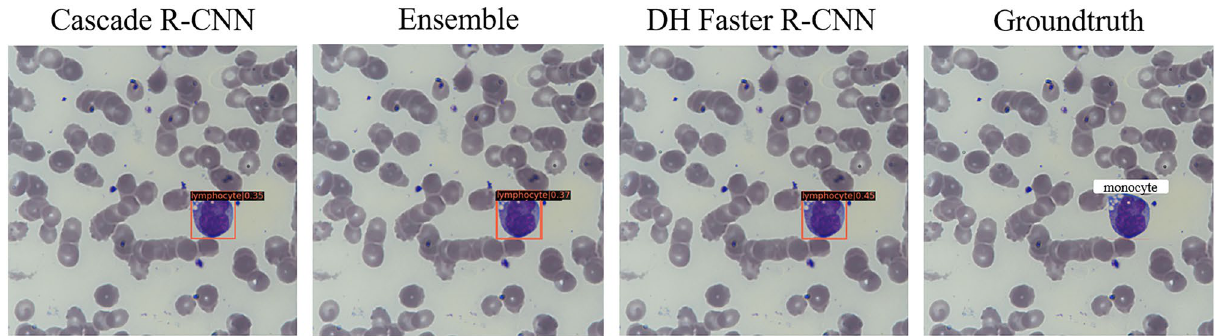
Figure 8. Qualitative true positive results yielded by different models. For the same leukocyte, Cascade R-CNN, Ensemble model, and DH Faster R-CNN all detect it as a lymphocyte, and experts labeled it a